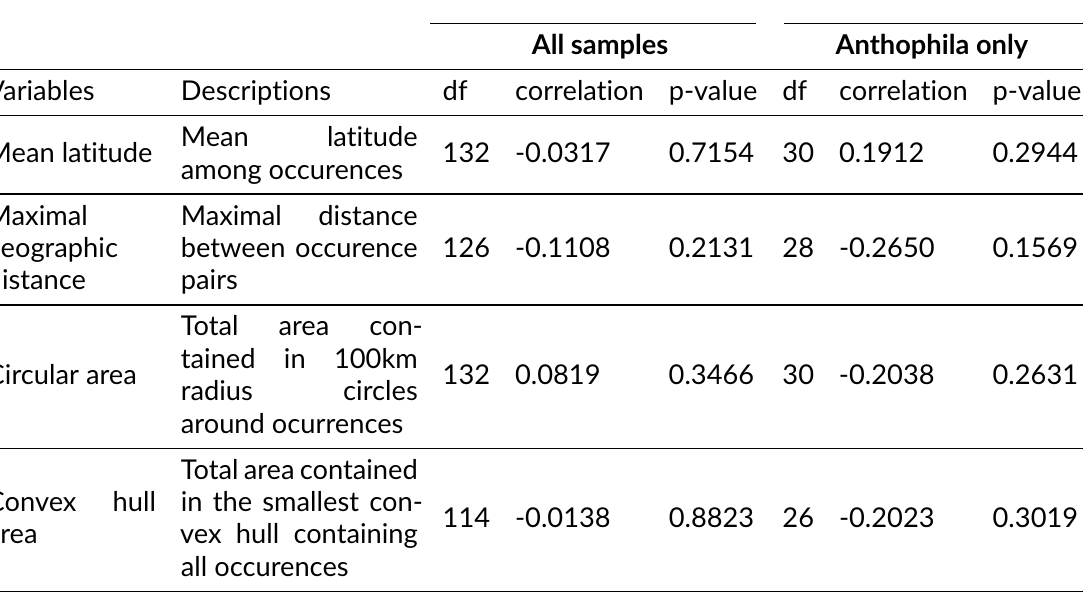
Table S5 – Correlation between corrected dN/dS values and proxies of the geographical range of species. The presented correlation coefficients are Pearson’s product moment correlation coefficient. P-values are those of the associated correlation